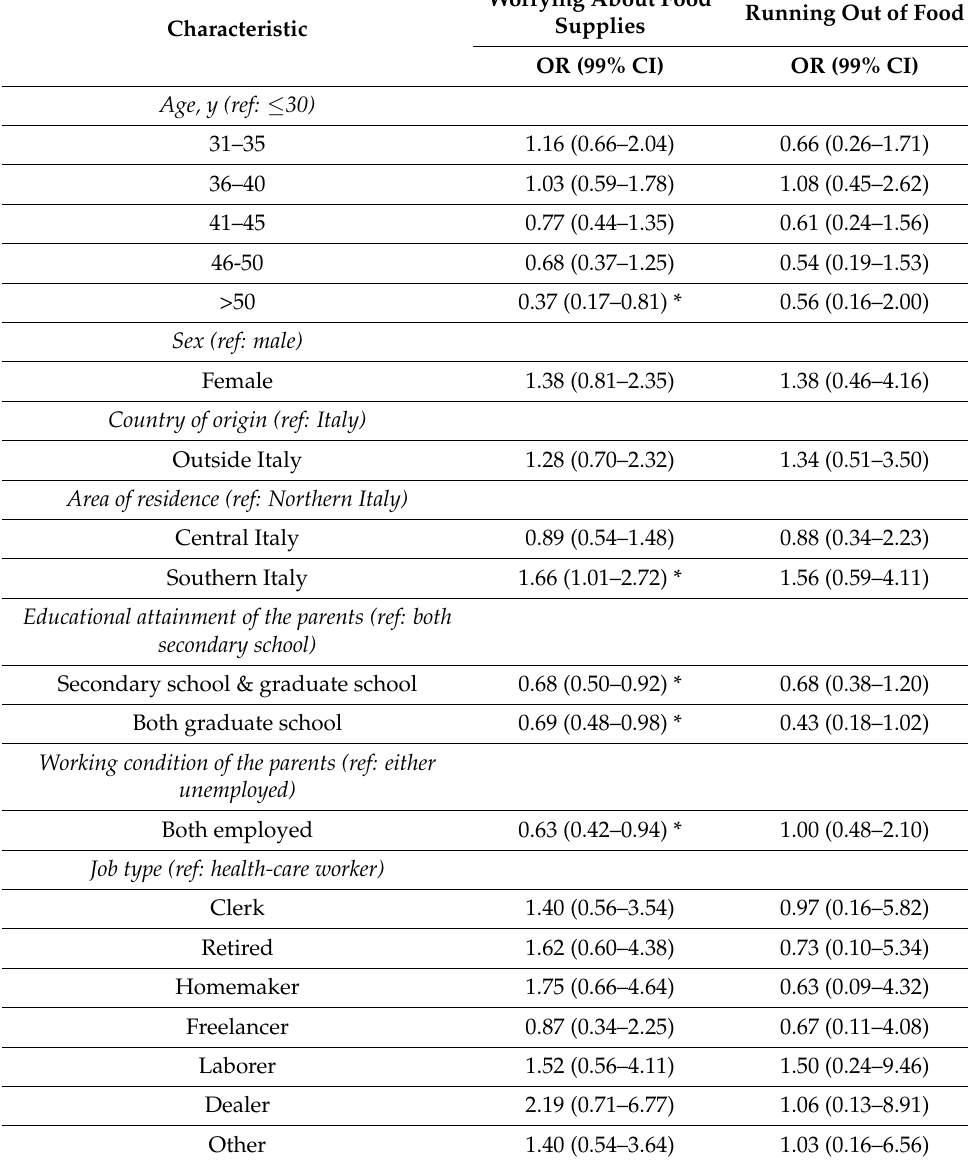
Table 3. Multivariable logistic regression analysis of increased vs. unchanged/decreased food insecurity after COVID-19 outbreak. Results are presented as odds ratios (ORs) and 99% confidence intervals (CIs). Worrying About Food Running Out of Supplies Characteristic